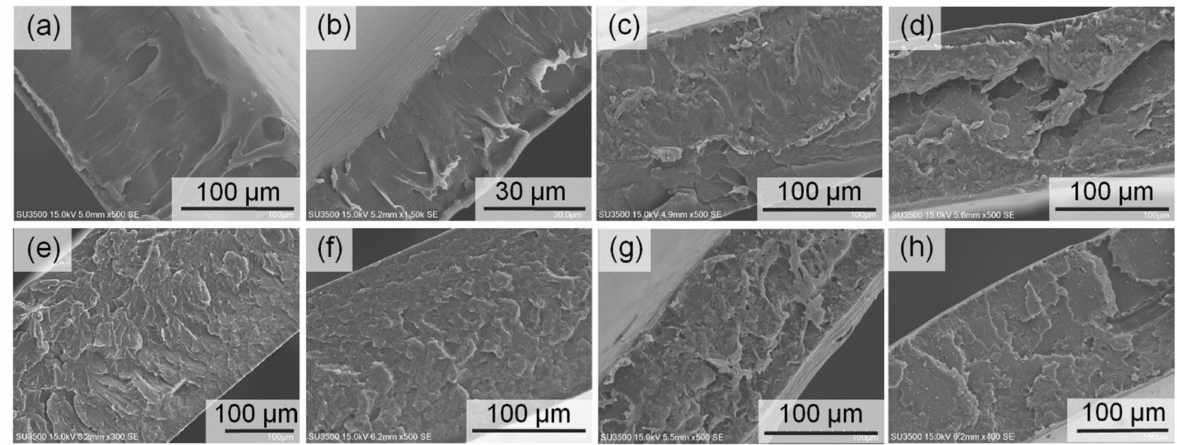
Figure 8. Cross-section images of the ( a ) neat PLA, ( b ) PLA/CNF, ( c ) PLA/CNFa2, ( d ) PLA/CNFa4, ( e ) PLA/CNFp2, ( f ) PLA/CNFp4, ( g ) PLA/CNFb2, and ( h ) PLA/CNFb4 composite